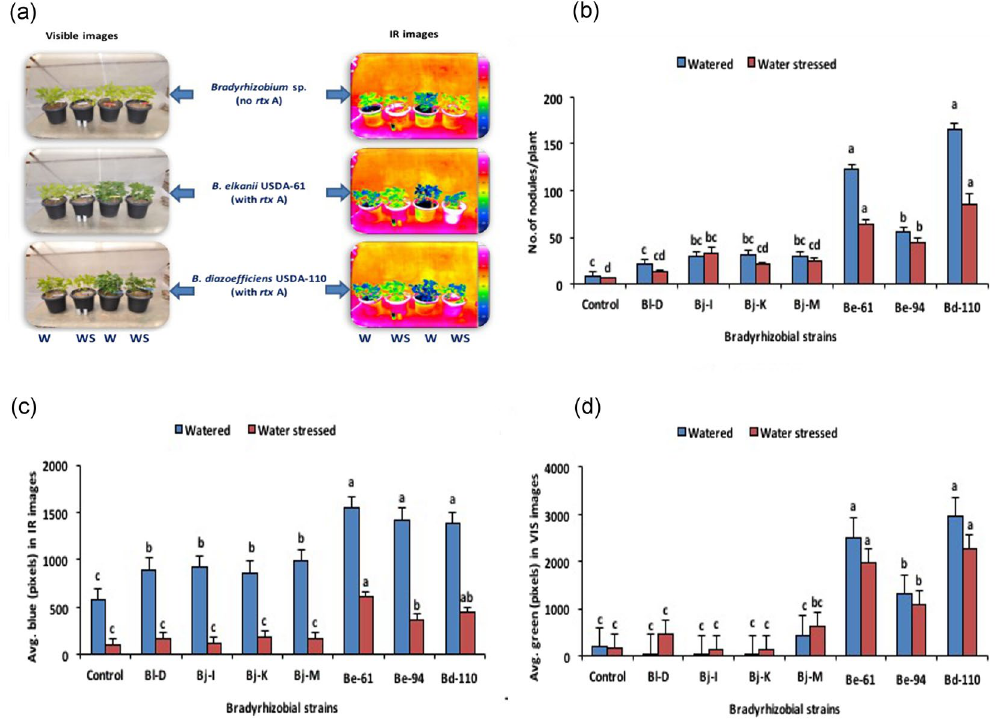
Figure 2. Comparative visible and IR thermal images showing plant canopy features of soybean plants inoculated and not inoculated with Rtx and non-Rtx bradyrhizobial strains ( a ) under watered and water- stressed conditions. Effect of the inoculation of Rtx and non-Rtx bradyrhizobial strains on root nodulation ( b ) and canopy measurements in IR thermal images ( c ) and visible images ( d ) of inoculated soybean plants under watered and water-stressed